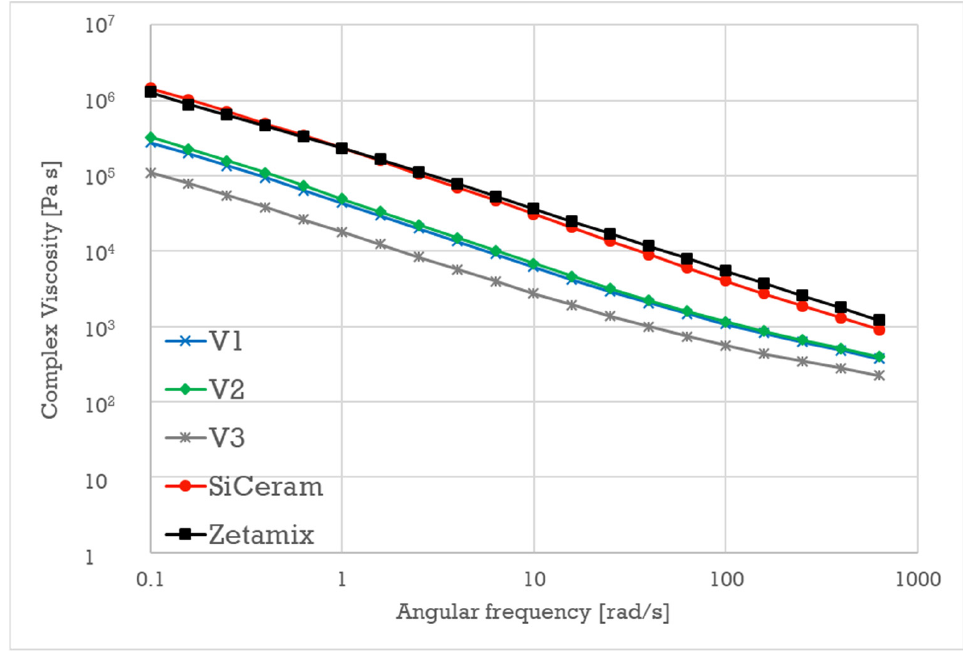
Figure 8. Complex viscosity of the V1, V2, V3, SiCeram and Zetamix filaments at 145 °C.